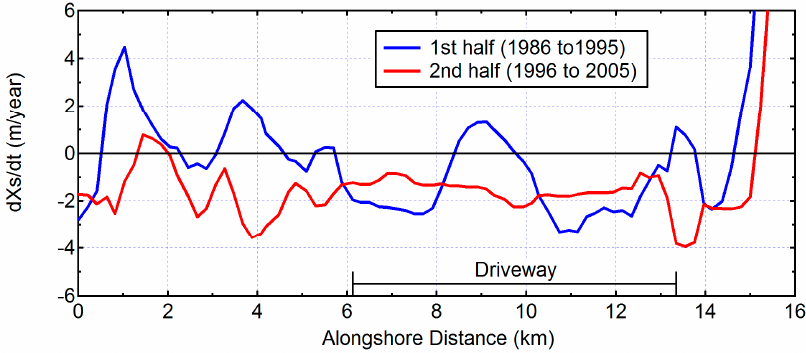
Figure 8. Alongshore comparison of shoreline change rates.